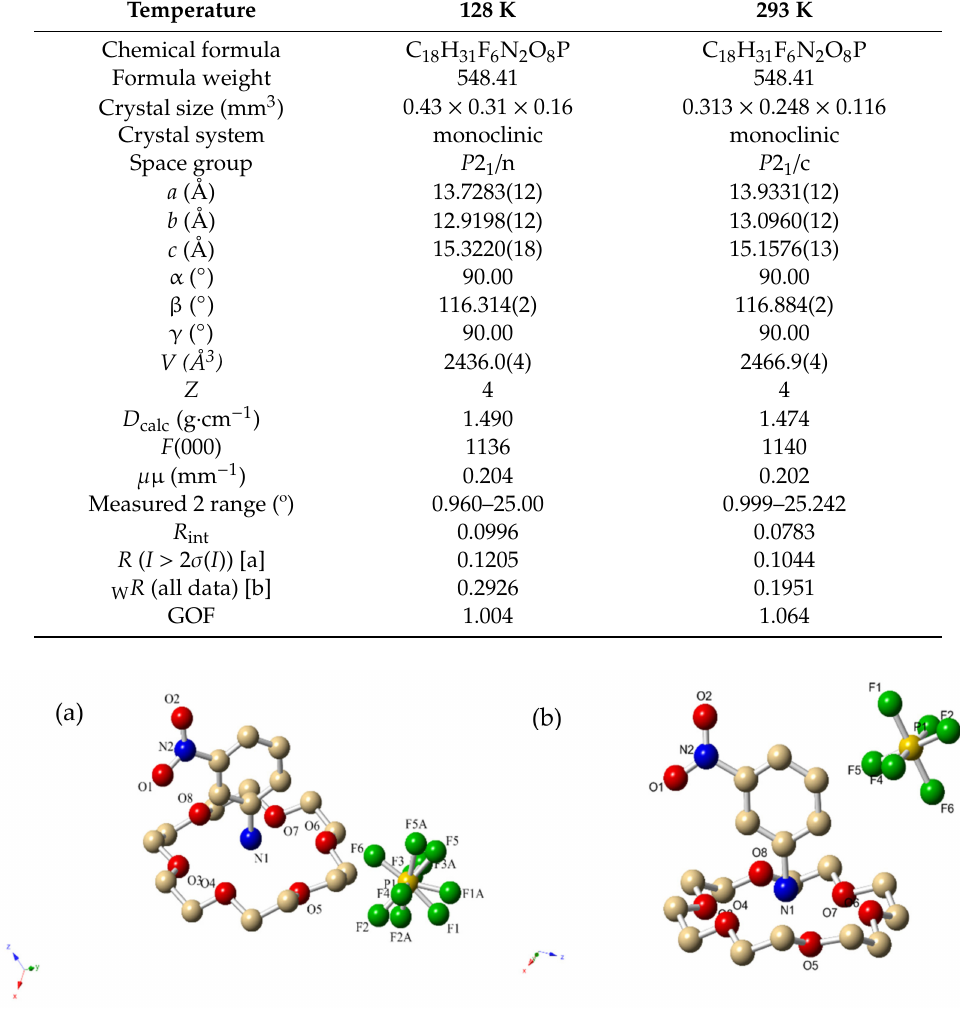
Figure 2. Asymmetric crystal structures of ( a ) the room-temperature phase and ( b ) the low-temperature phase of